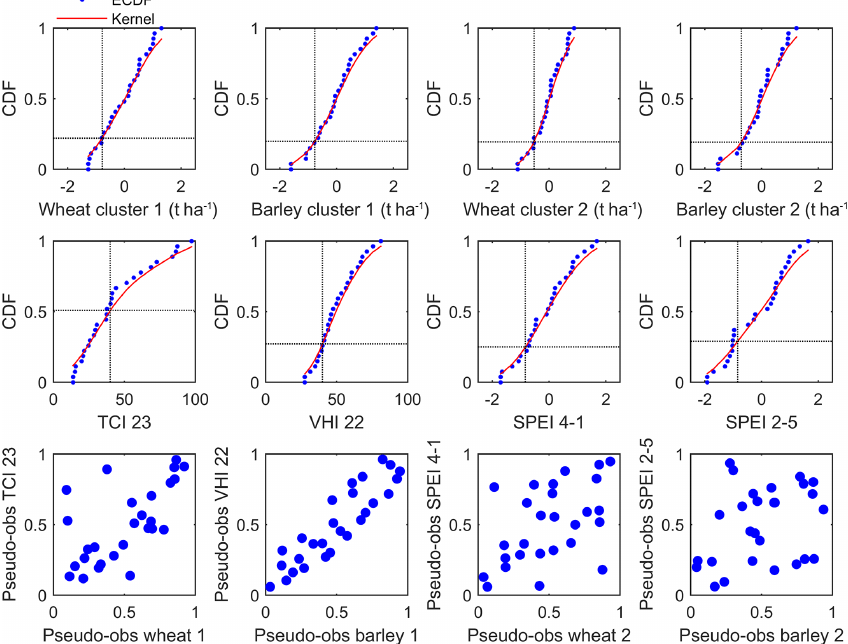
Figure 3. Empirical cumulative distribution functions (ECDF, blue points), kernel density estimation of the CDF (red line), crop loss and drought thresholds (dotted black vertical line), respective marginal probabilities of crop loss and drought occurrence (dotted black horizontal line), and pseudo-observations (scatter) of the margins on the interval [0,